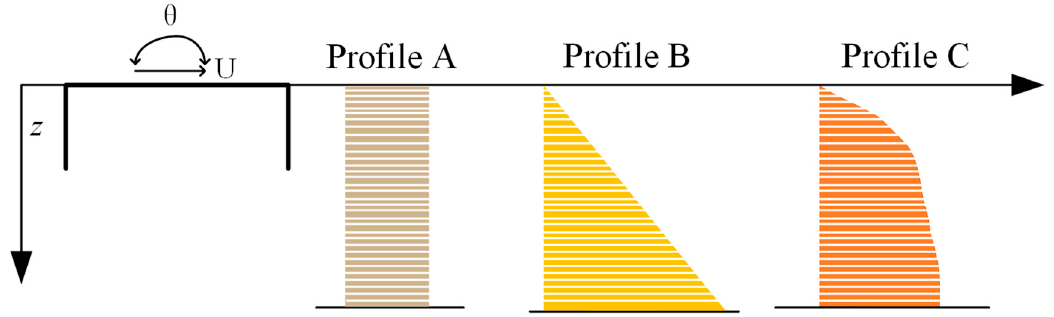
Figure 8. Soil profiles considered for dynamic impedances of WSBF. Table 1. Parameters and cases selected in the parametric analysis.